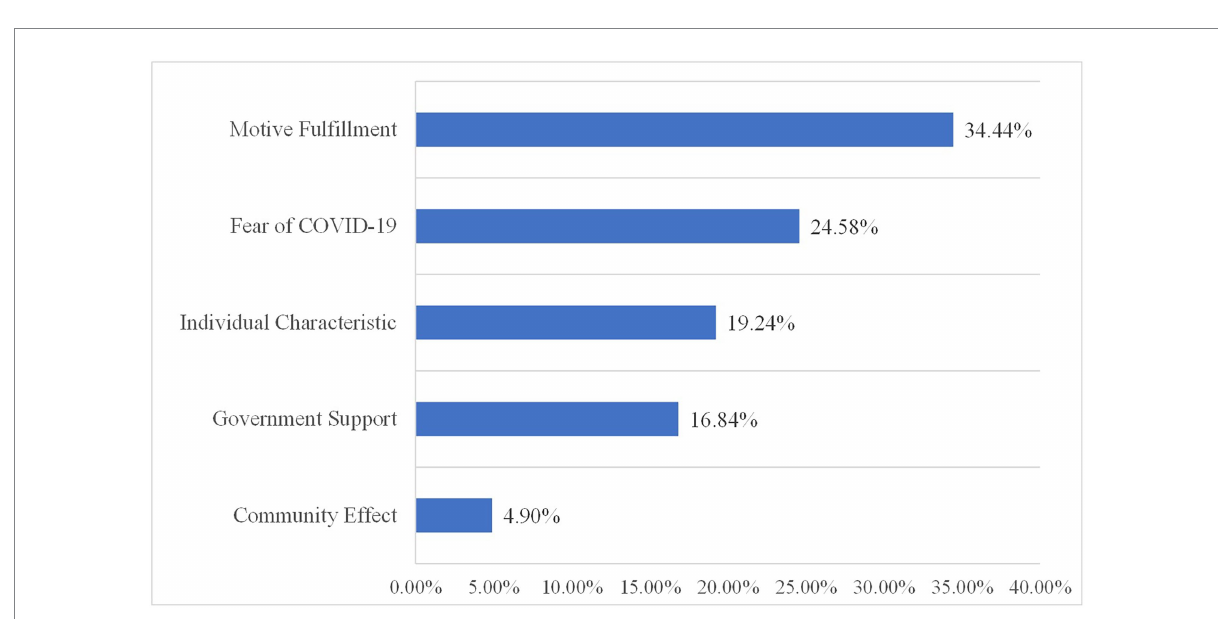
FIGURE 5 Factors associated with volunteerism amid the COVID-19